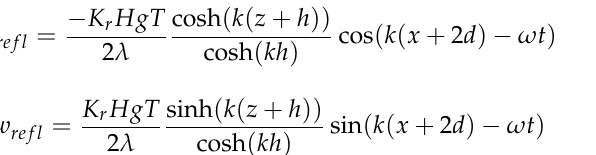
Figure 2. Schematic representation of the cross section of an incident and reflected wave in deep water